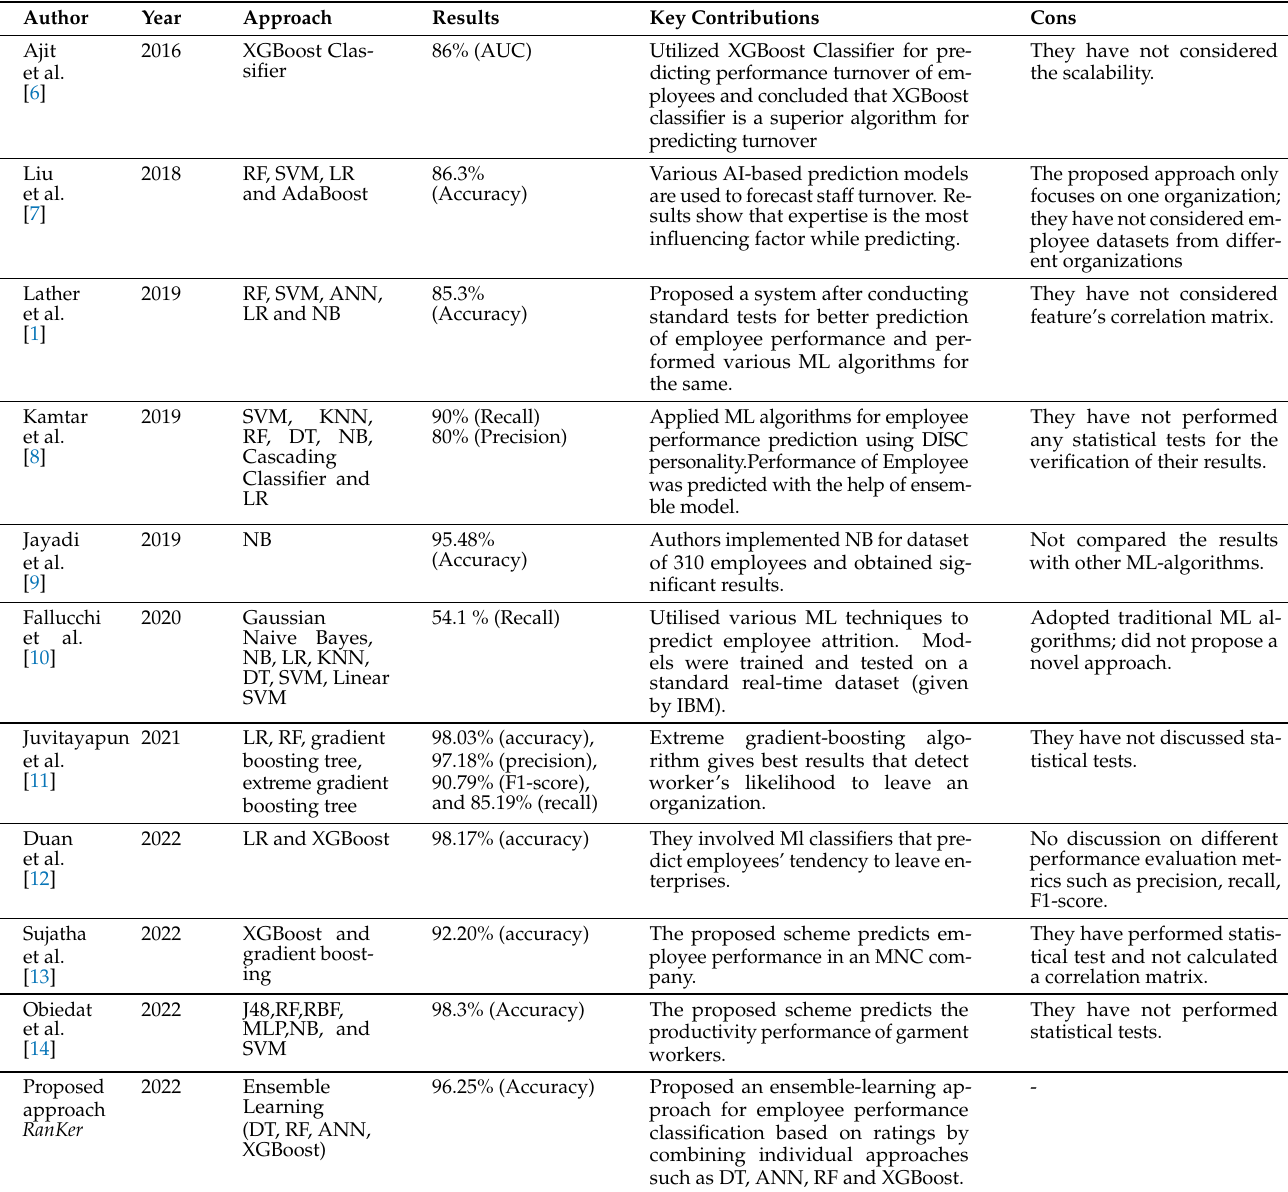
Table 1. Comparison of various existing approaches with our proposed